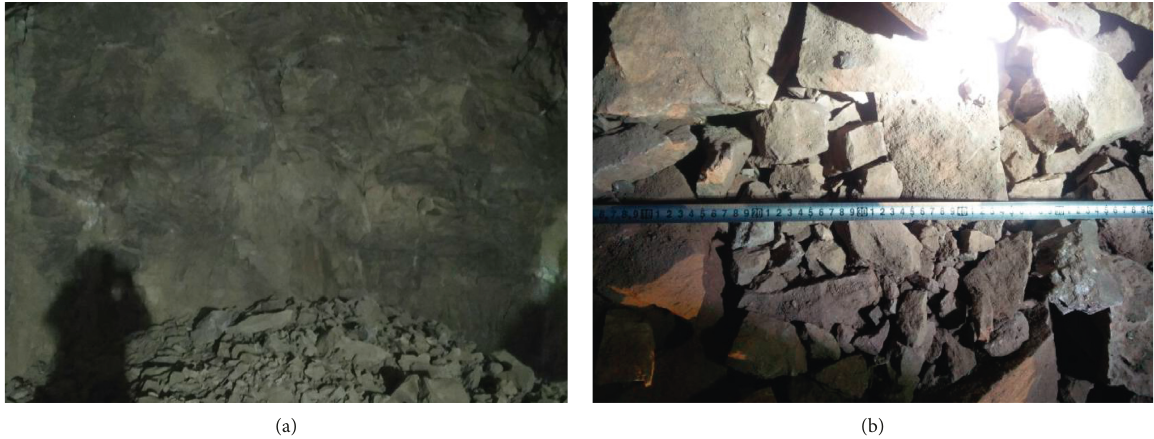
Figure 8: Details of field tests after blasting. (a) Tunnelling face. (b)